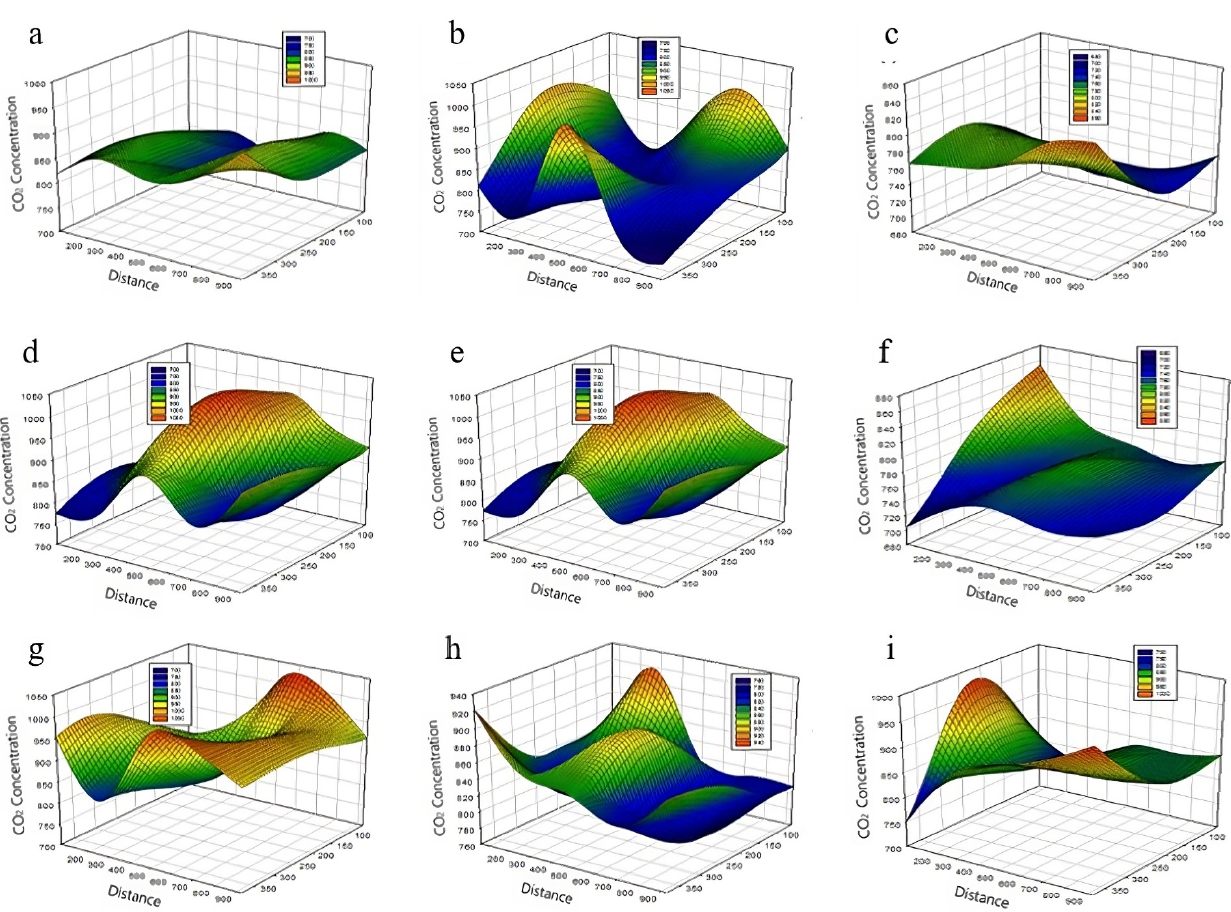
Figure 8. Changes in CO 2 concentration (ppm) in upper location (in centimeters): ( a ) 10–11 a.m., ( b ) 2–3 p.m., ( c ) 5–6 p.m.; in middle location: ( d ) 10–11 a.m., ( e ) 2–3 p.m., ( f ) 5–6 p.m.; and in lower location: ( g ) 10–11 a.m., ( h ) 2–3 p.m., ( i ) 5–6 p.m. during the CS experimental periods.